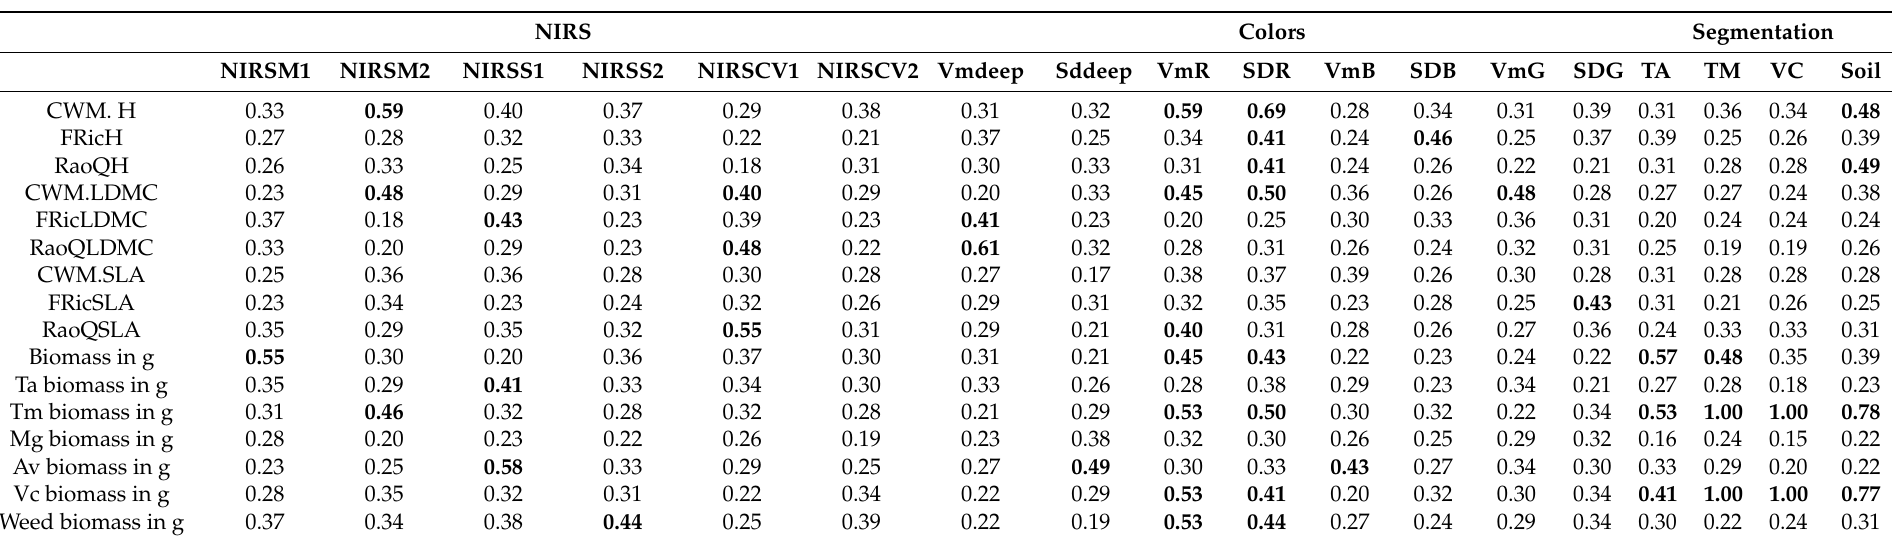
Table 3. Maximum correlation coefficient (MIC) between the vegetation descriptors and the NIRS variables (the color analysis of the image and the percentage extracted from the segmentation). The correlation coefficients in bold represent a significant